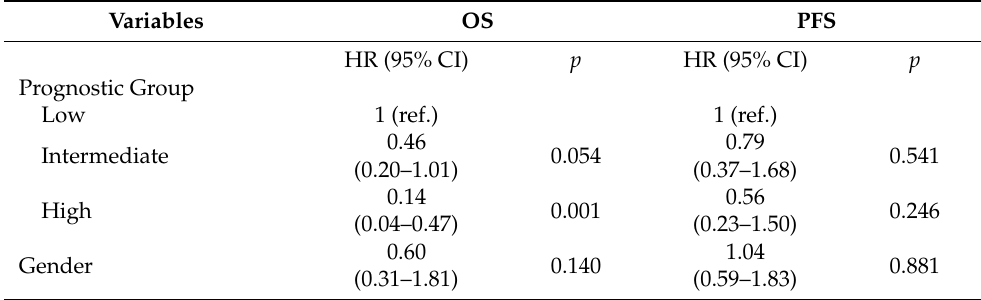
Table A3. Multivariate analysis of OS including the prognostic groups defined according to ACE and VEGF-A plasma